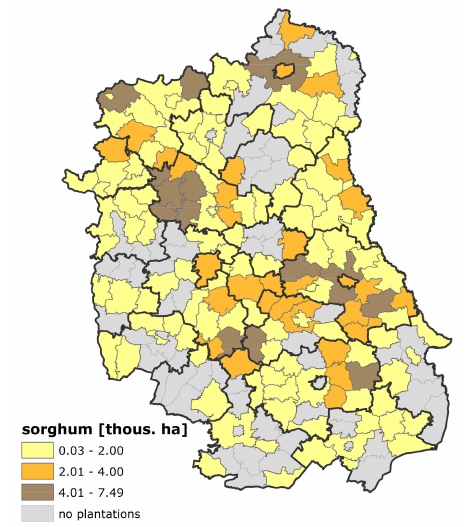
Figure 4. Spatial allocation of sorghum’s supply by gminas (NUTS-5